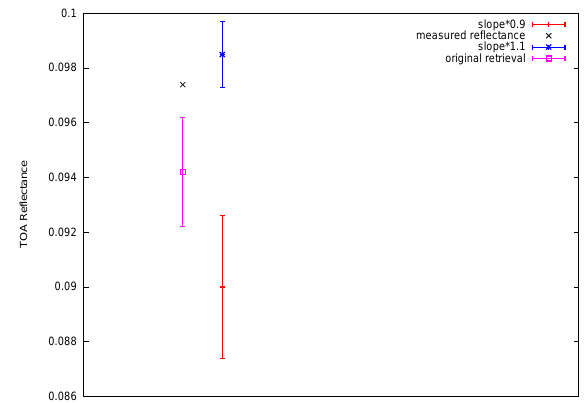
Fig.5. SensitivityoftheretrievedTOAreflectanceat660nmonchangesintheslope NDVI SWIR 660 / 2130 . The black cross is the observed TOA reflectance at 660 nm and the magenta square is the result from the original retrieval (FMW=0.5). The red and the blue markers are results from retrievals (FMW=0.5) where the slope NDVI SWIR 660 / 2130 is 10 % smaller (0.9) and 10 % larger (1.1), respectively. Theerrorbarsshowhowmuchthecombinationofthedustandfineaerosolmodels affects the results. The top of the bar indicates unmixed dust model (FMW=0.0) while the bottom of the bar is for the unmixed fine model (FMW=1.0).